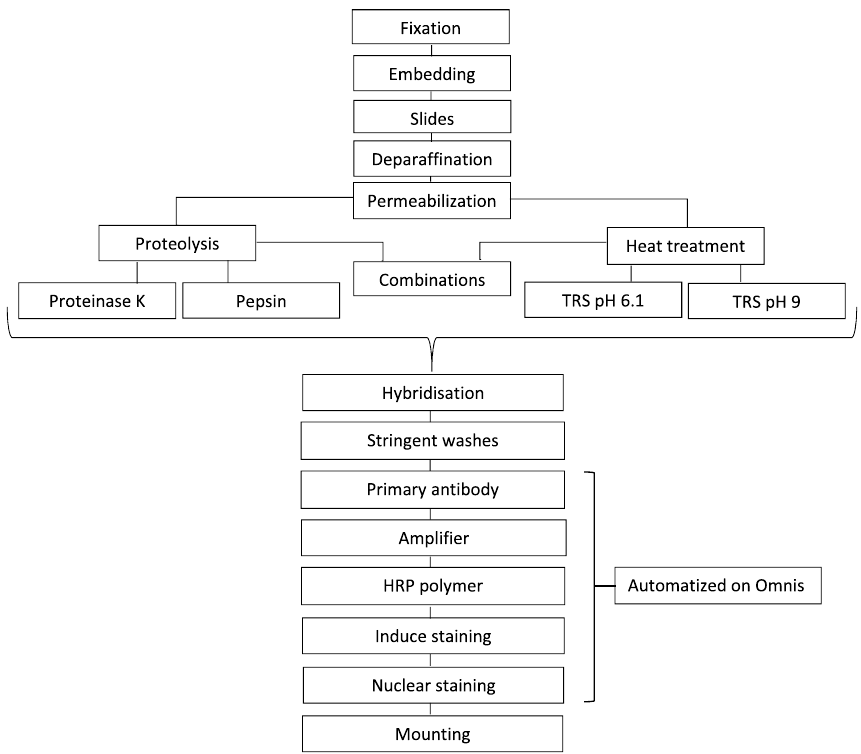
Figure 6. Flowchart of microRNA in situ hybridization. The first four boxes at the top indicate the standard procedure, including tissue fixation, tissue embedding (paraffin embedding), cutting of slides and permeabilization. Permeabilization is achieved with proteolysis, Heat-mediated microRNA Retrieval (HmiRR) or a combination of HmiRR followed by enzymatic treatment with pepsin. After permeabilization, all slides were subjected to the same procedure: hybridization and stringent washes. Application of primary antibody, amplifier, and horseradish peroxidase (HRP) polymer and nuclear staining could be automatized on a Dako Omnis platform. To preserve the tests, all slides were mounted at the